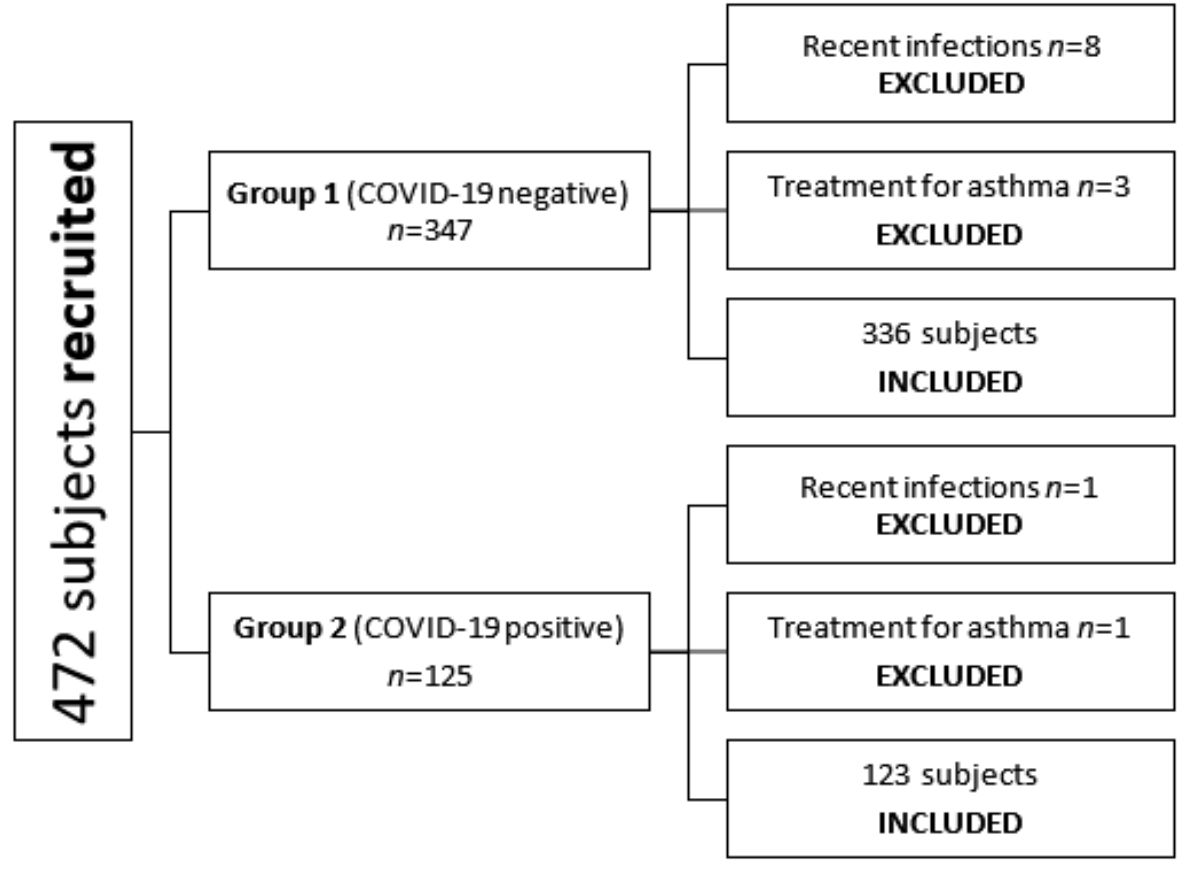
Figure 2. Patient selection.